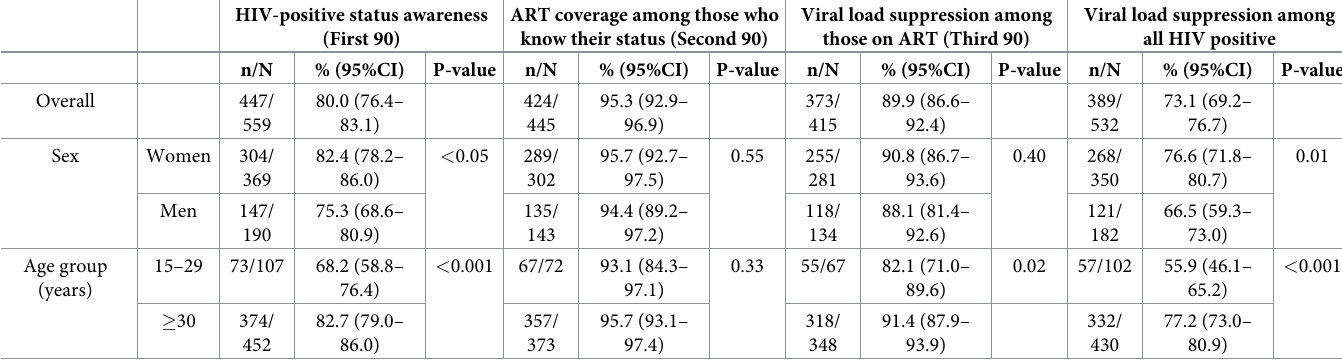
Table 2. UNAIDS 90-90-90 targets results and viral load suppression among all HIV-positive stratified by sex and age group. HIV-positive status awareness (First